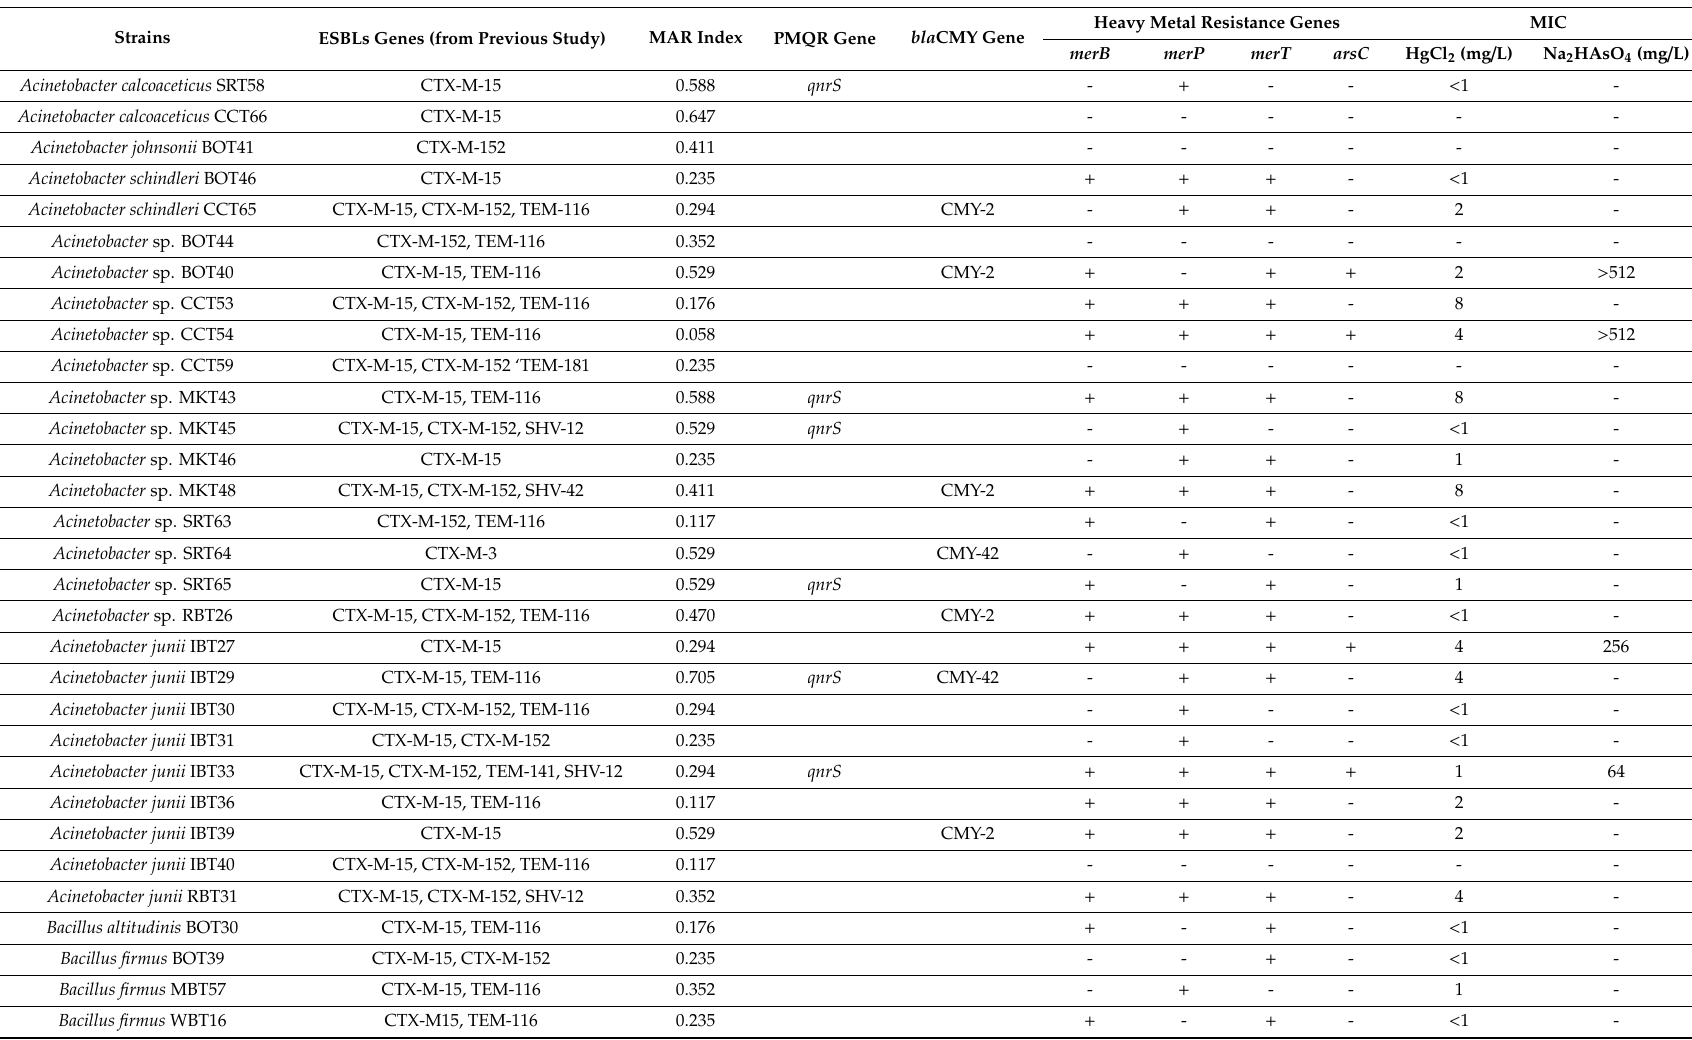
Table 2. Antibiotic and heavy metal resistance genes among tested bacterial isolates and their corresponding minimum inhibitory concentrations (MICs).